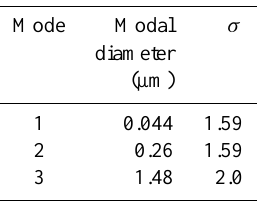
Table 1. The modal diameters and geometric standard deviations ( σ ) for the previous sea spray aerosol parameterisation imple- mented in NorESM (Kirkevåg et al.,